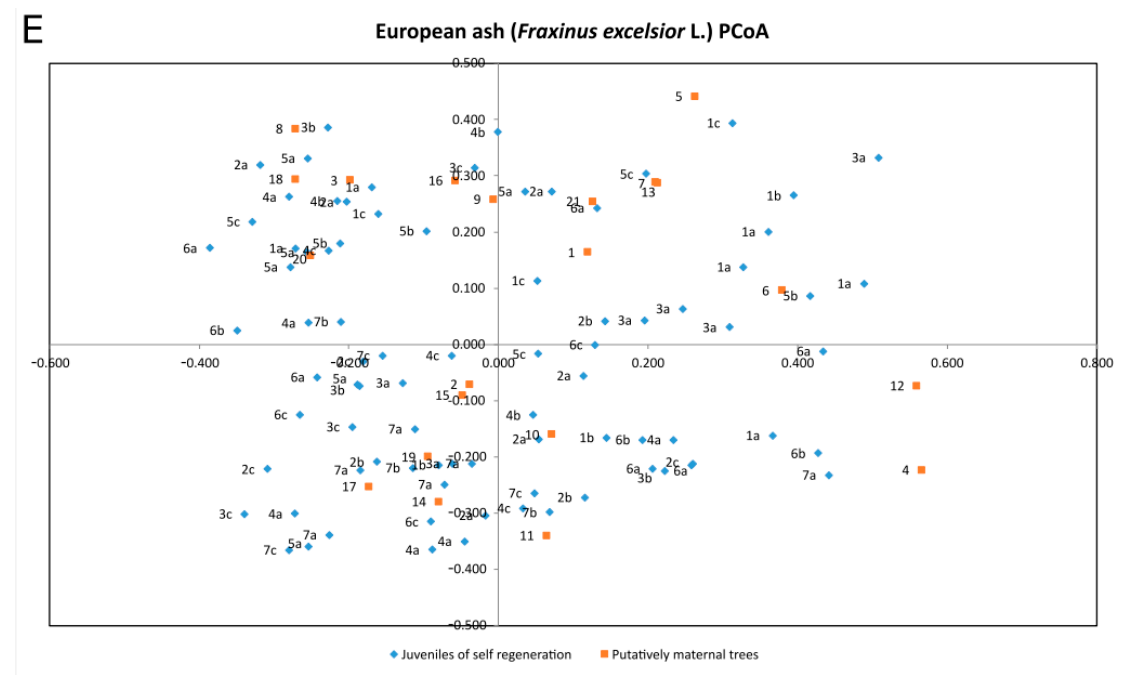
Figure 3. Principal coordinate analysis (PCoA) diagrams for five investigated broadleaved tree species (( A )— Q. robur ; ( B )— B. pendula ; ( C )— P. tremula ; ( D )— A. glutinosa ; ( E )— F. excelsior ), showing genetic differentiation among microsatellite multilocus genotypes (MLGs) of the respective species based on Nei’s genetic distance matrix. Blue diamonds indicated with numbers from 1a to 7a, 1b to 7b, and 1c to 7c indicate MLGs of sampled self-regenerating juveniles in the corresponding numbered sampling plots (see Figure 1). Orange squares indicated with numbers 1–30 denote MLGs of sampled putatively maternal trees of the same species.